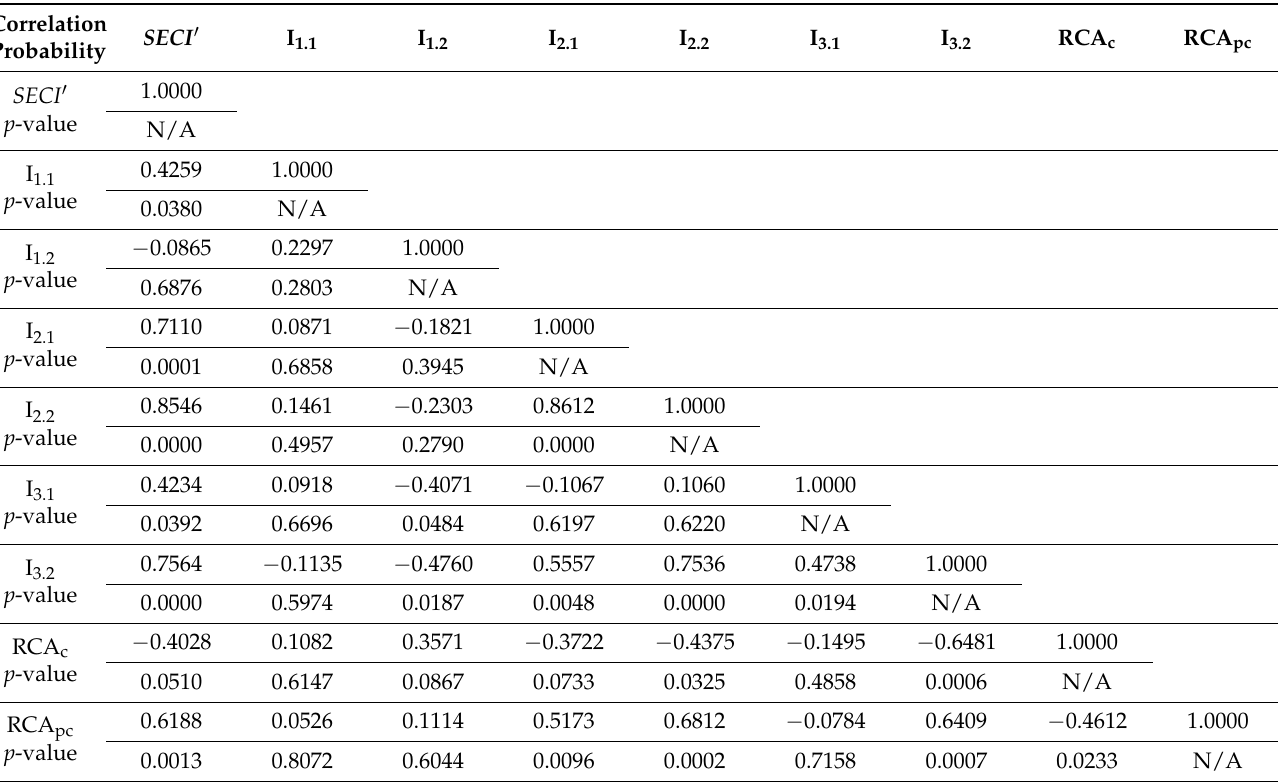
Table 4. The correlation matrix of the normalized sustainable economic competitiveness index ( SECI (cid:48)